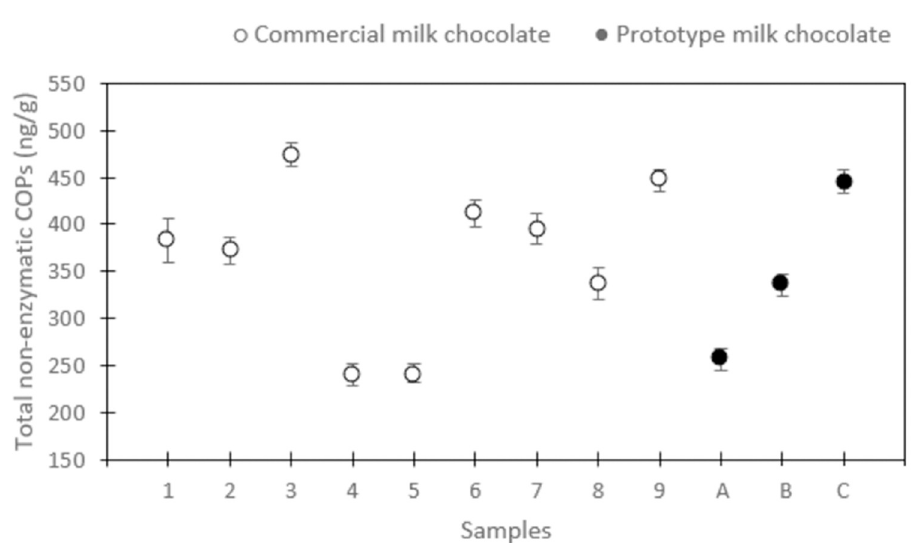
Fig 1. Distribution of non-enzymatic cholesterol oxidation products (COPs) in commercial and prototype milk chocolate tablets made with whole milk powder (WMP) of 20, 120, and 180 days of shelf-life,